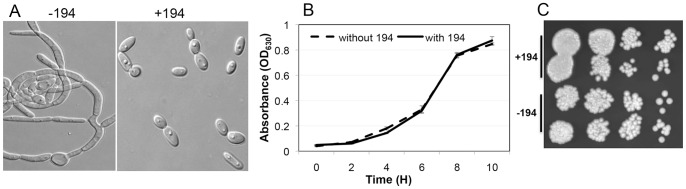
Effect of a Gymnema sylvestre fraction (#194) on Candida albicans yeast-to-hypha conversion, growth and viability.(A) Stationary-phase C. albicans yeast cells grown in YNB medium were resuspended (1×105 cfu/ml) in RPMI 1640 medium +50 mM glucose (buffered with HEPES 50 mM, pH 7.3) containing equal volume of DMSO (-194) or in the presence of fraction #194 and incubated in microtiter plates at 37°C with gentle shaking for 16 h. Cells were viewed under microscope and photographed. (B) Growth of C. albicans in the presence or absence of fraction #194 (but with equal volume of DMSO). Yeast cells were incubated in YPD liquid medium at 30°C in microtiter wells without shaking for the indicated times and growth of cells was determined by measuring absorbance (OD630). Experiments were repeated at least twice each with triplicates. Error bars indicate standard deviations (SD). (C) Viability of cells exposed to vehicle control or fraction #194 in RPMI medium at 37°C were determined by removing aliquots of cell suspensions at t = 8 h of growth, vortexing for 30 seconds at top speed and diluting them ten fold serially before spotting 5 µl on YPD agar plates. Plates were incubated at 30°C for 16 h and then photographed.